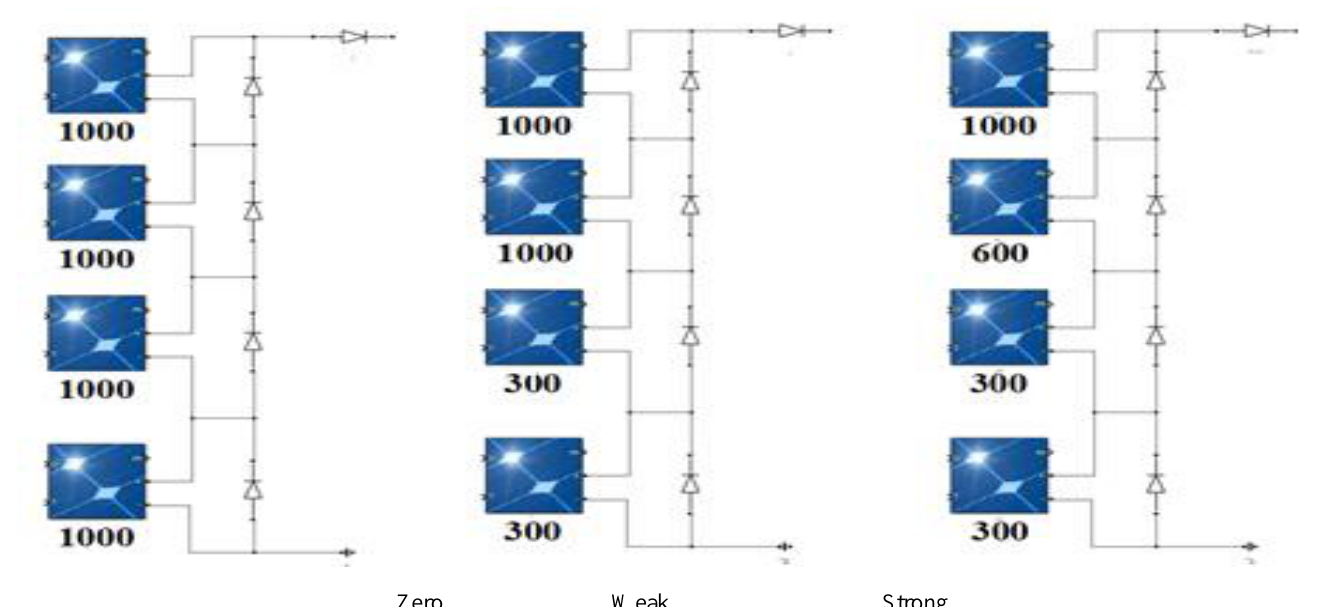
Zero Weak Strong Fig. 5. A 4S PV array with zero, weak, and strong partial shading conditions